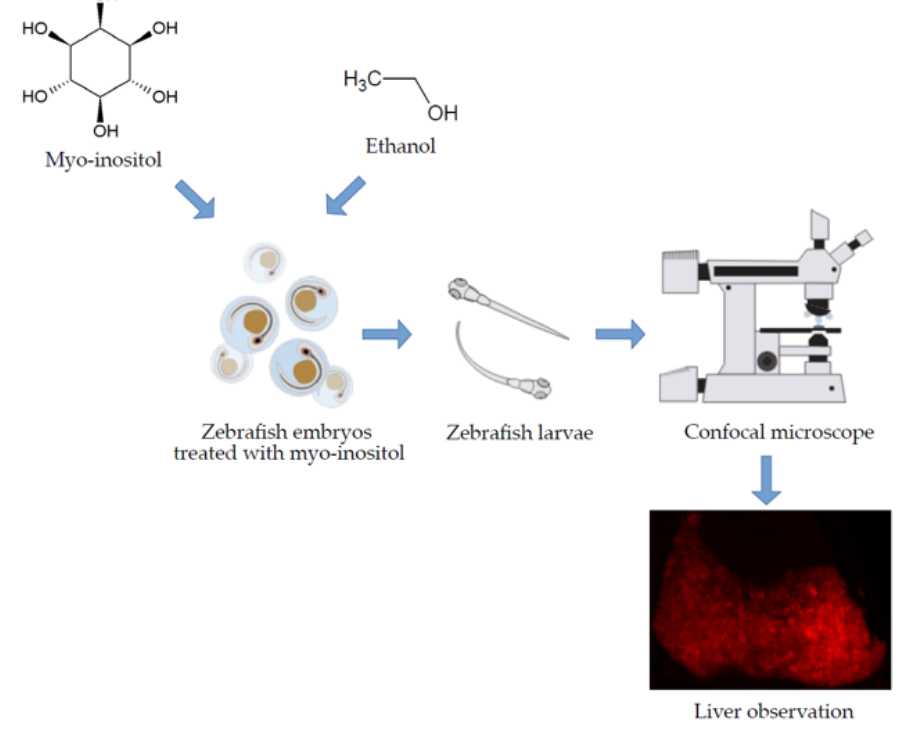
Figure 1. Zebrafish as a model of alcoholic liver disease.